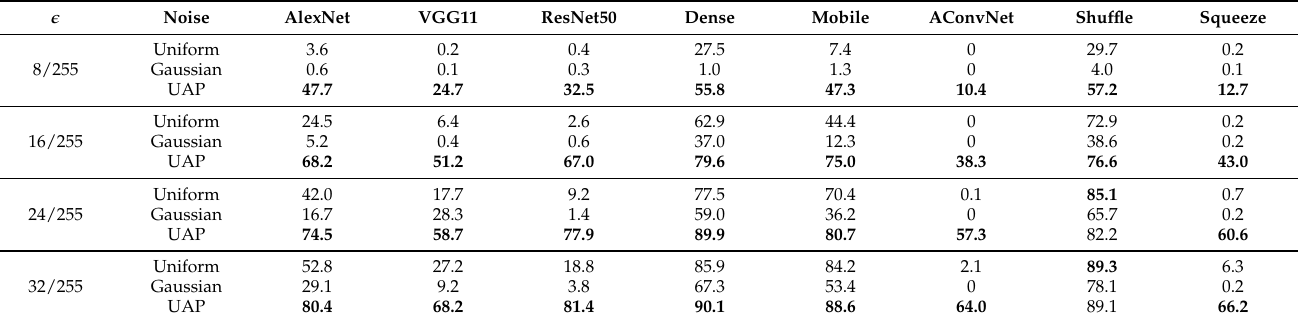
Table A1. Fooling ratio (%) of DF-UAP with MobileNetV2 as substitute model and various (cid:101) . The deviation of Gaussian noise is set to (cid:101) /3 and the results of random noise are averaged on 10 runs.